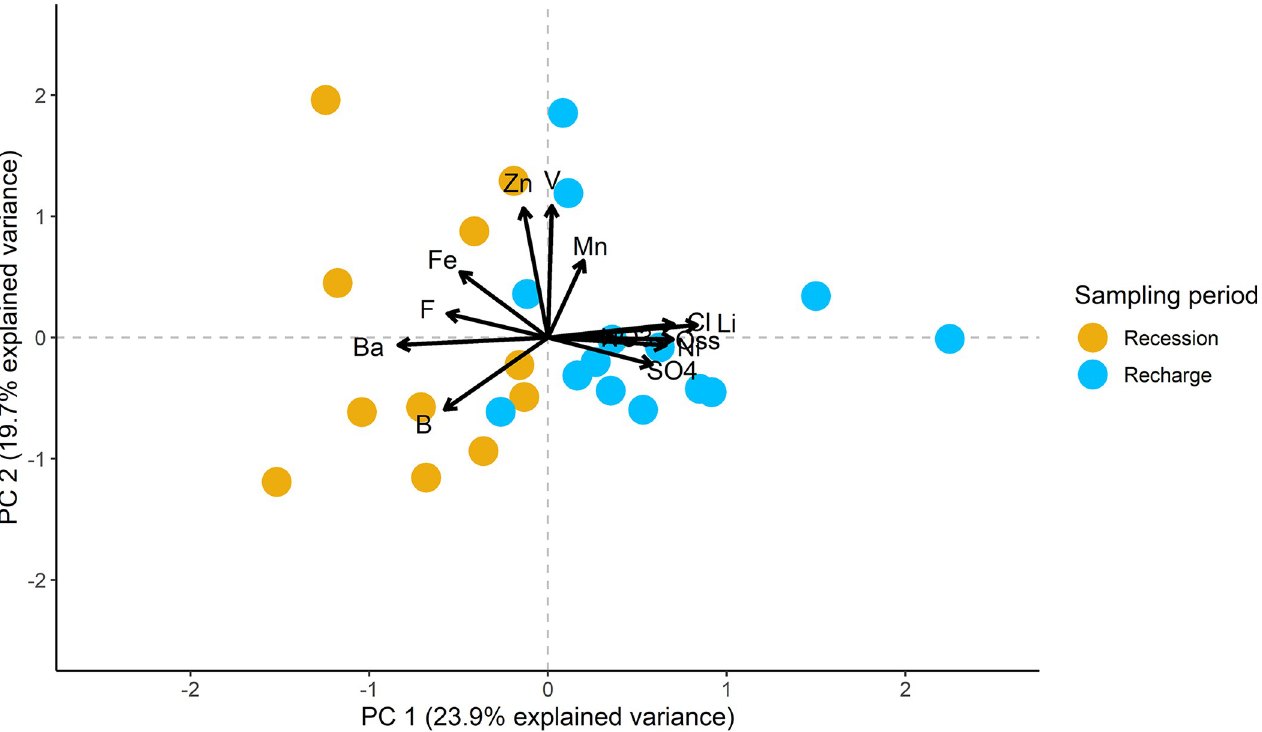
Fig 11. Plot of PCA2 (only spring water samples) according to sampling period. Acronyms were used for permanganate oxidation (Oss), NO 3- (NO3), Cl - (Cl), F - (F), and SO 42- (SO4).